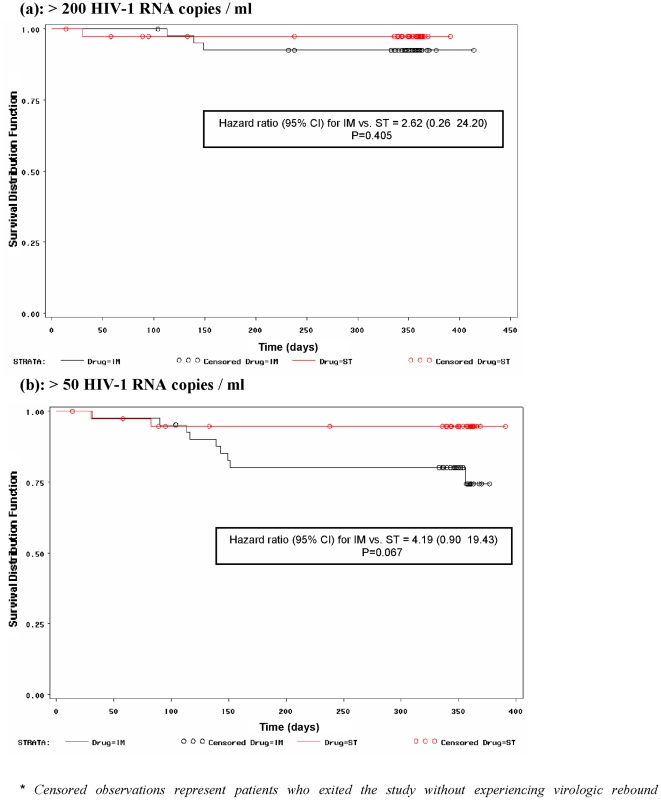
Kaplan Meier Analysis for time to confirmed virologic rebound.(a): >200 HIV-1 RNA copies / ml. (b): >50 HIV-1 RNA copies / ml.* Censored observations represent patients who exited the study without experiencing virologic rebound.